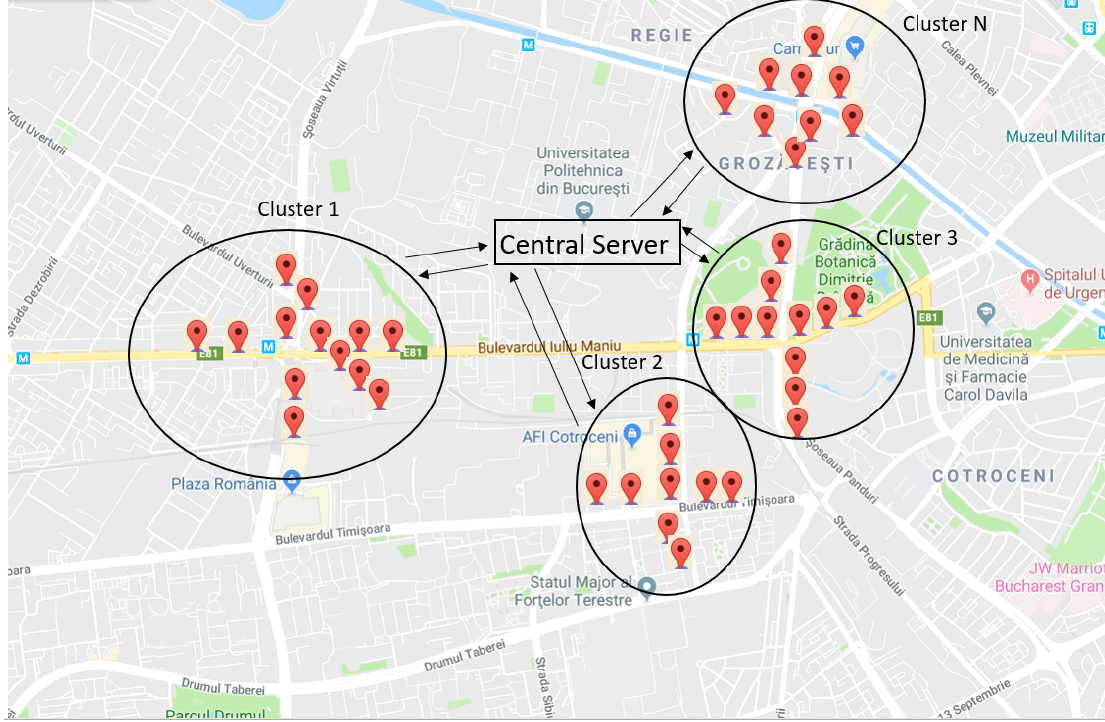
Figure 1. Geographical areas representing